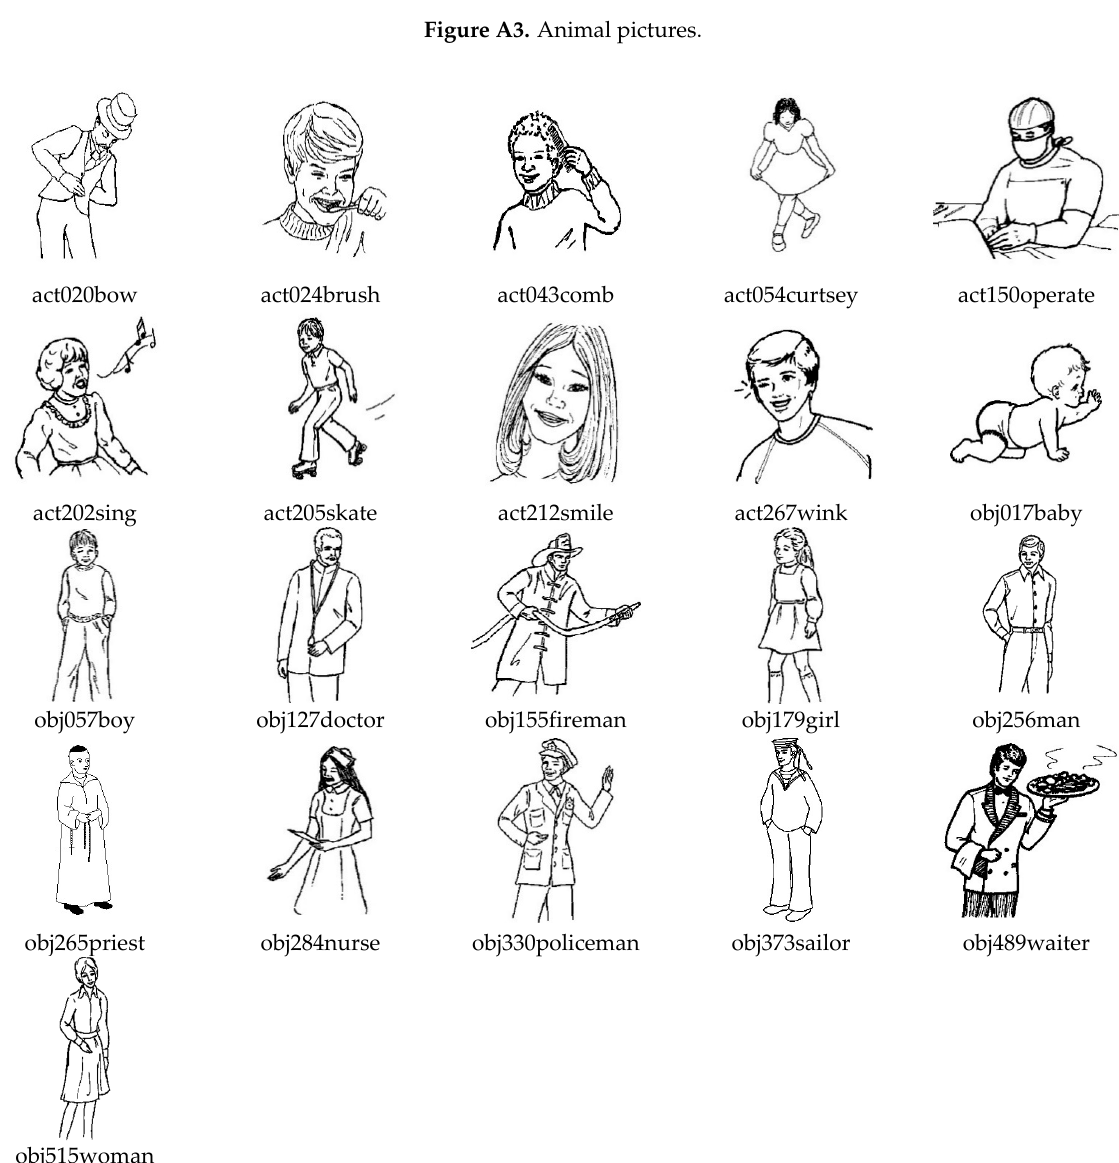
Figure A4. Human pictures.